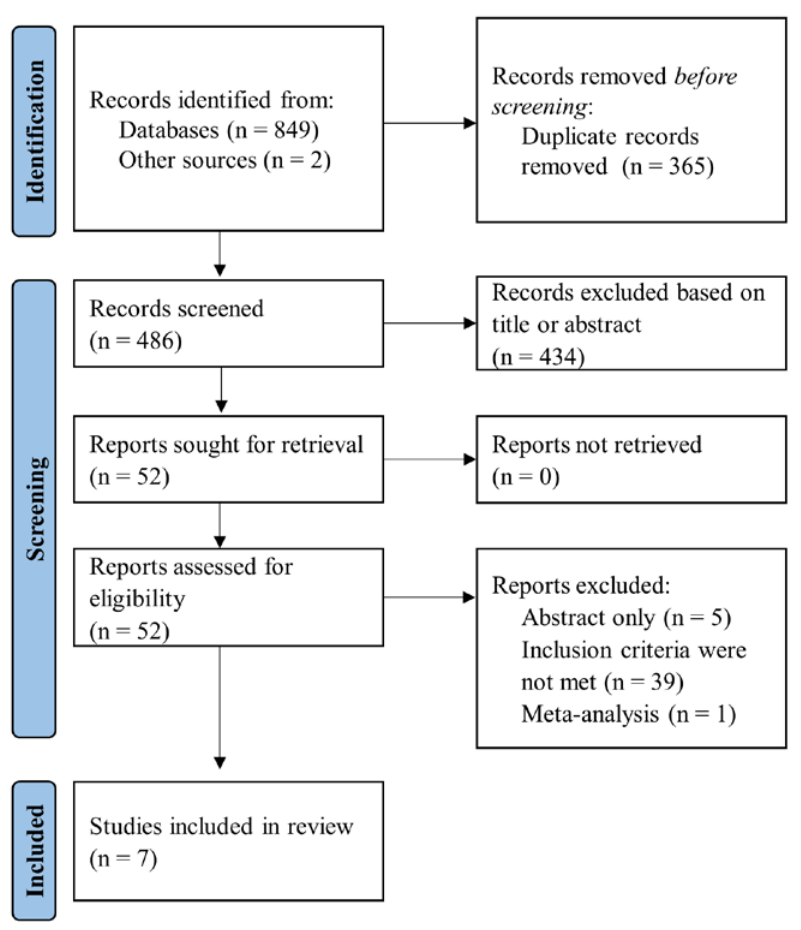
Figure 1. Flow diagram of selected studies in present systematic review.